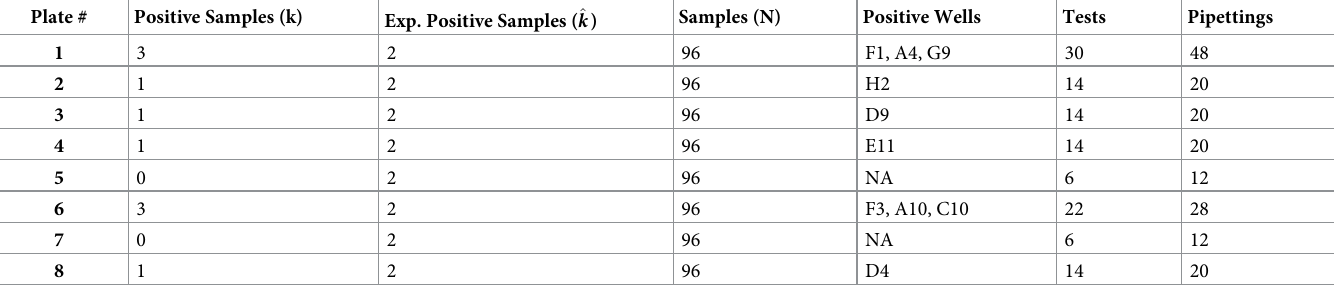
Eight 96-well plates were filled with background DNA from complex cow milk microbiome samples and 10 randomly chosen samples had C. burnetii DNA spiked in. The table shows the number and location of the positive samples in each 96-well plate and the number of tests and pipettings required to identify the positive samples using our Modified 3-Stage pooling